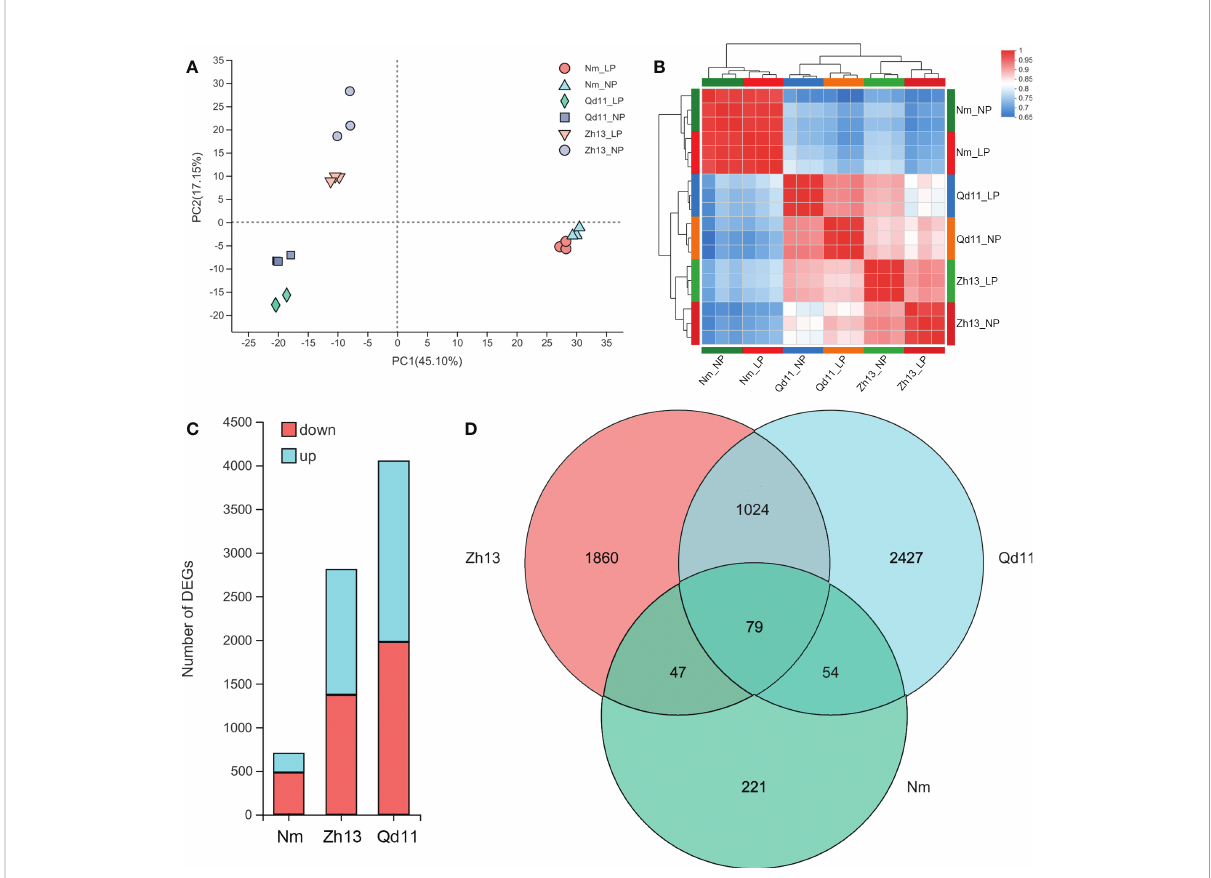
FIGURE 3 Principal component analysis of the genes expressed in Qd, Zh13, and Nm in response to normal (NP) and low (LP) soil phosphorus availability (A) ; Pearson correlations for Qd, Zh13, and Nm in response to NP and LP treatments. The colors represent the distances among the samples (B) ; principal component analysis of the expressed genes (B) ; number of differentially expressed genes in each variety (C) ; Venn diagram of the three varieties of differentially expressed genes (D) . Varieties abbreviations: Qd, Qian Dou 11; Zh13, Zhonghuang 13; Nm, Niu Mao